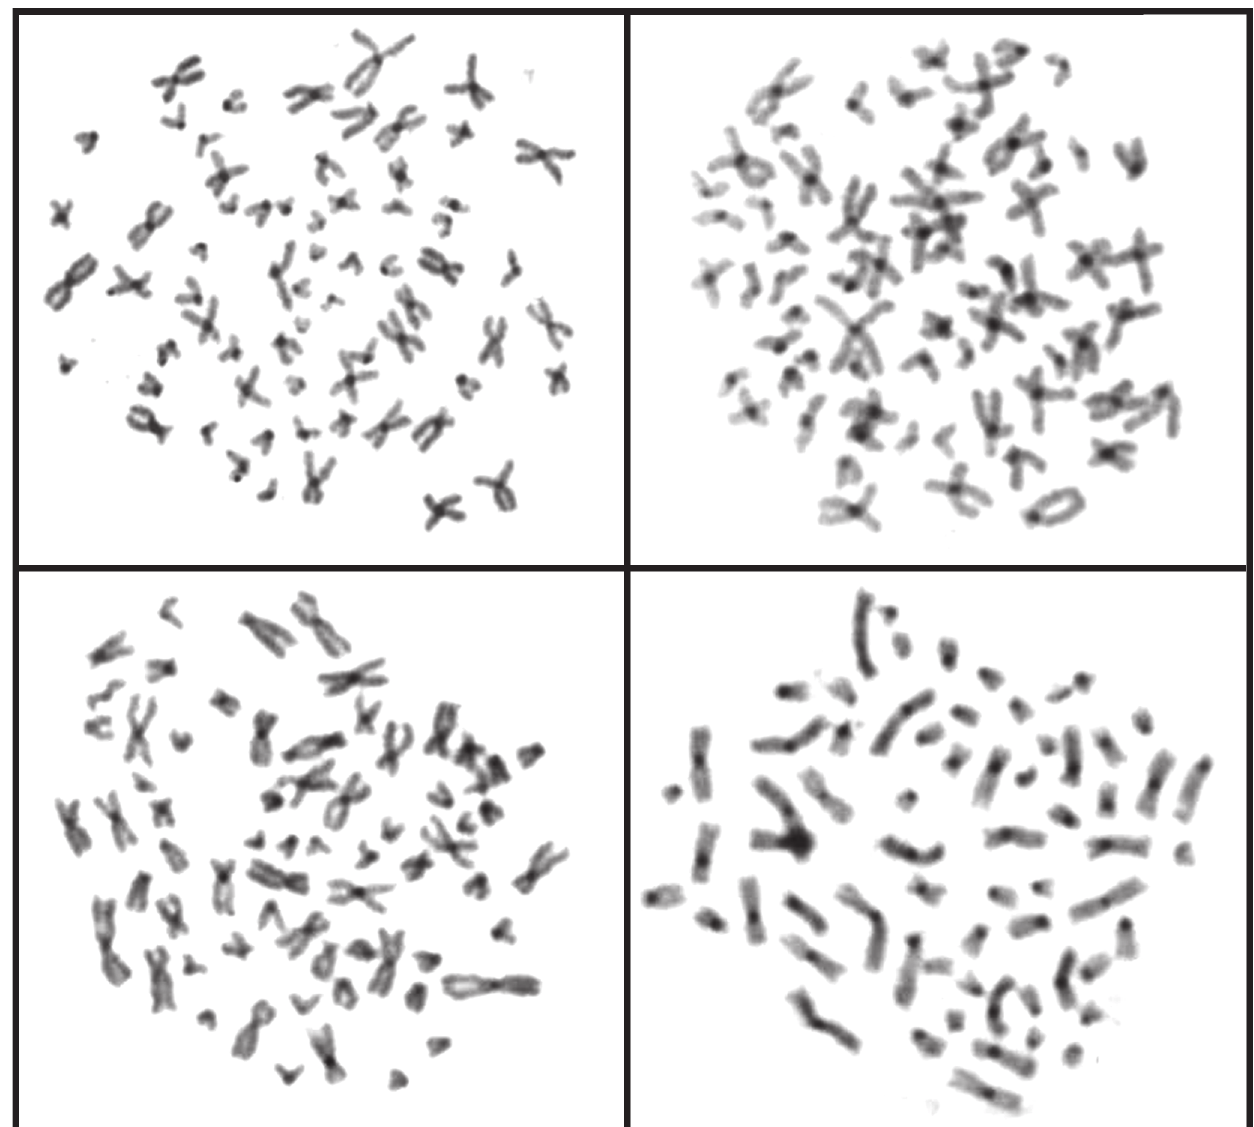
Fig. 6. Somatic metaphases of Potamotrygon aff. motoro , the population of Porto Rico ( a ), population of Ilha Solteira ( b ), identification of constitutive heterochromatin. Metaphases of Potamotrygon falkneri sample from Porto Rico ( c ) and Ilha Solteira ( d ), analysis of constitutive heterochromatin after C-banding